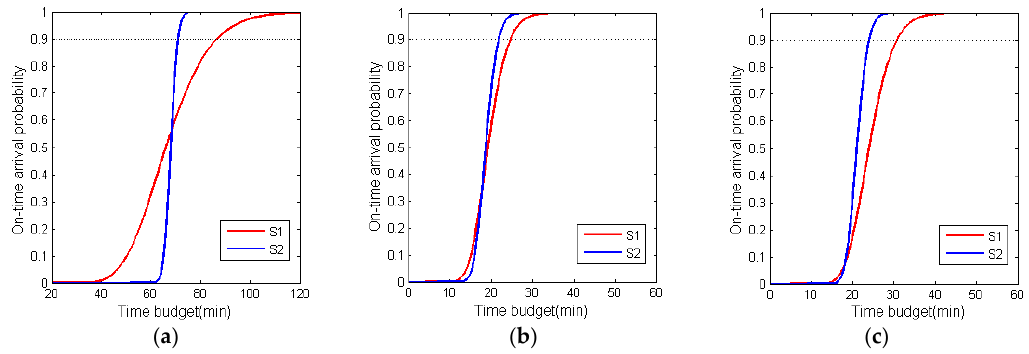
Figure 9. Cumulative probability density curves of the open routes of S1 and S2. ( a ) Open route 0; ( b ) Open route 1; ( c ) Open route 2.